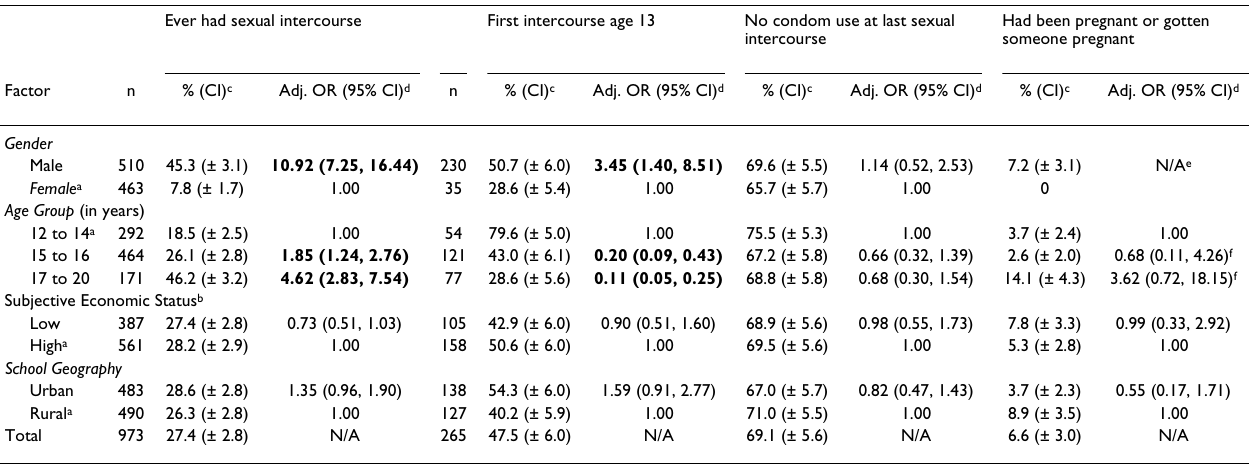
Table 5: Prevalence of selected sexual and reproductive behaviors among eighth and ninth grade secondary students attending public schools in a central region of El Salvador by socio-demographic characteristics, 1999 Ever had sexual intercourse First intercourse age 13 No condom use at last sexual